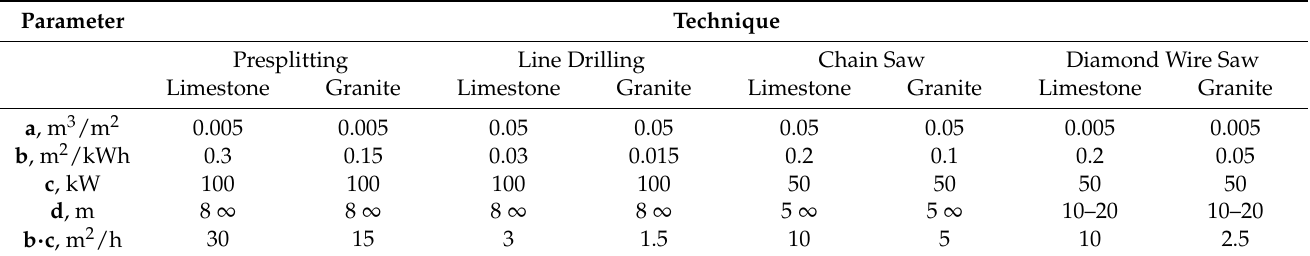
Table 3. Comparison of the possible cutting techniques, according to some selected